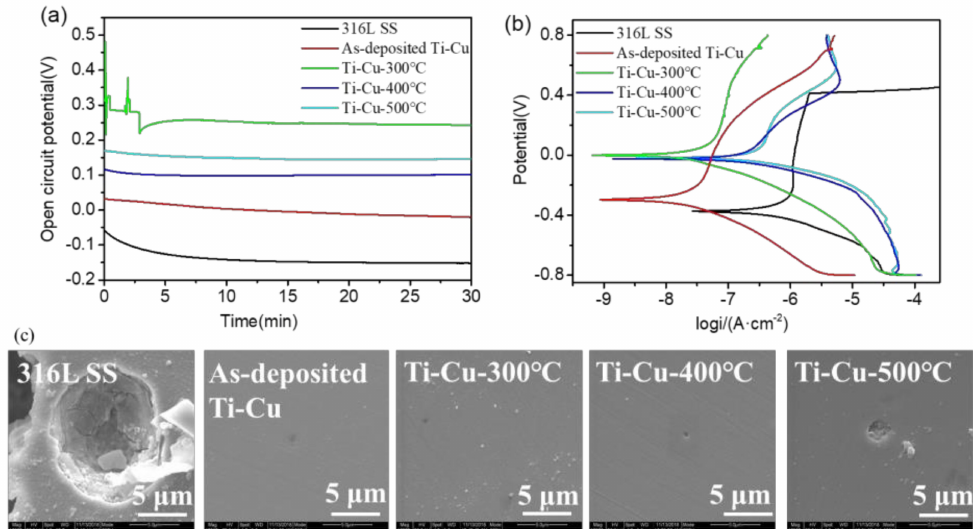
Figure 9. ( a ) Open circuit potential and ( b ) polarization curves of the deposited and annealed Ti–Cu coatings (300 ◦ C, 400 ◦ C, and 500 ◦ C) deposited on 316L SS substrates; ( c ) Surface morphologies evaluated by SEM images after electrochemical corrosion for the deposited and annealed Ti–Cu coatings on 316L SS substrates.